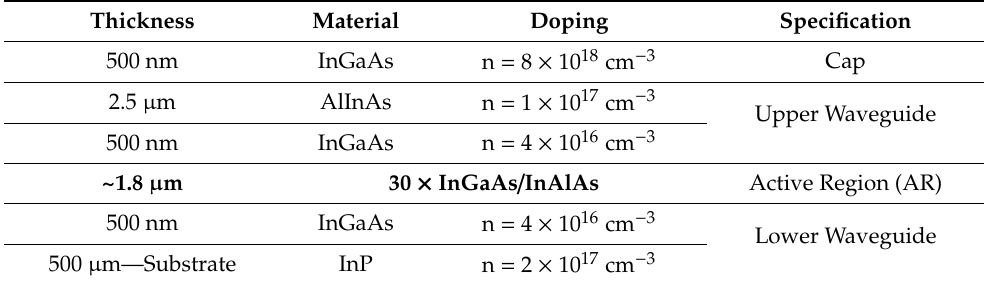
Table 4. Layer structure of lattice matched In 0.53 Ga 0.47 As / In 0.52 Al 0.48 As / InP